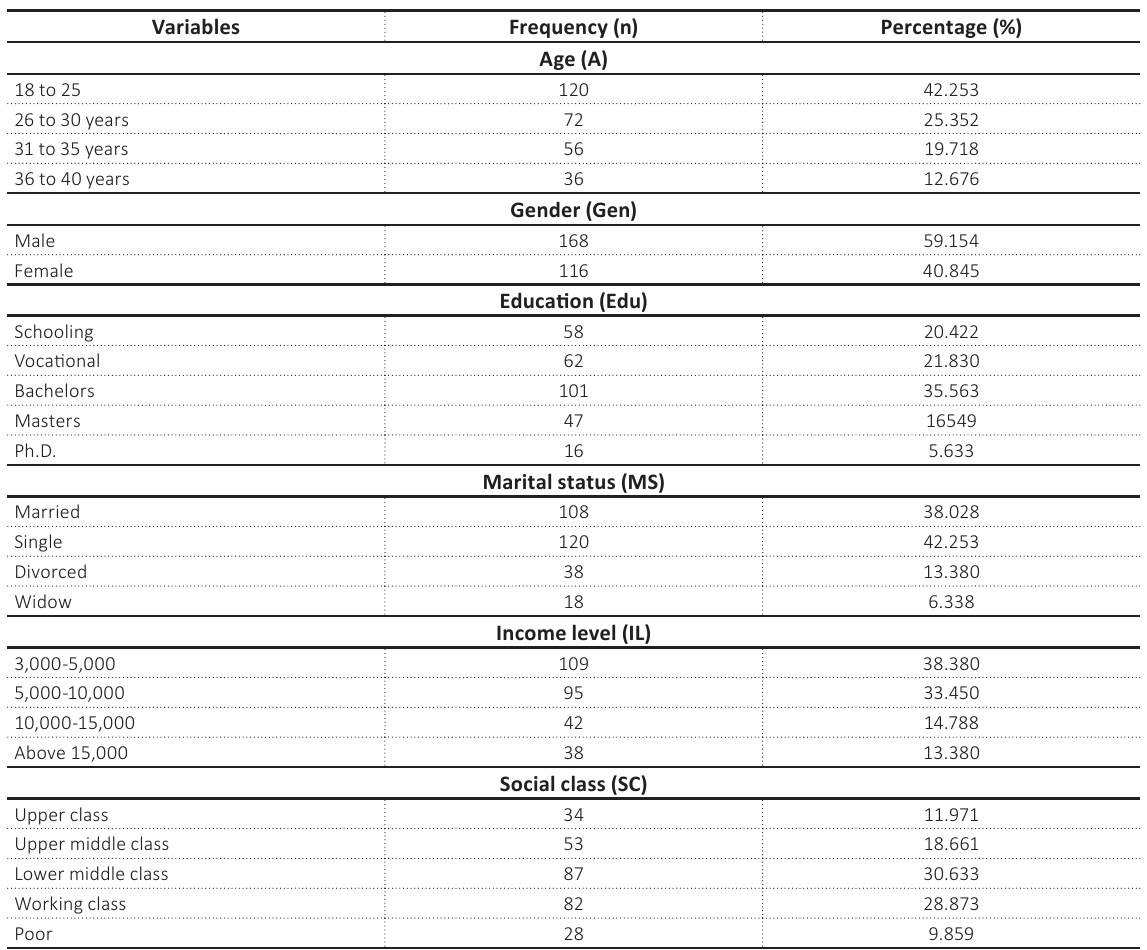
Table 1. Demographic profile of